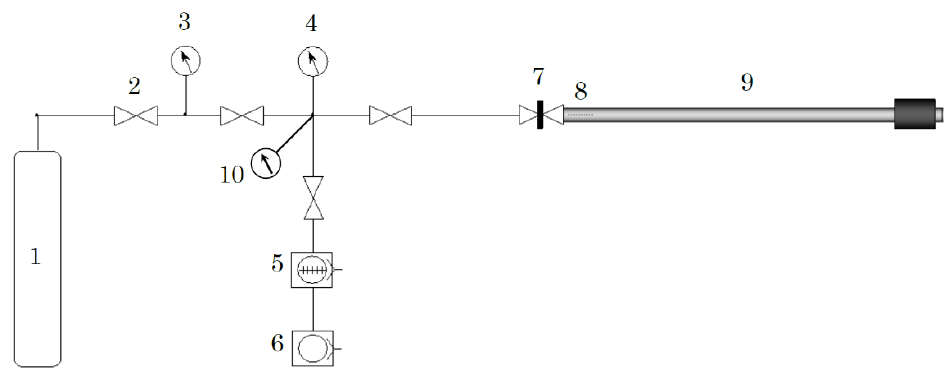
Figure 15. Schematic illustration of the home-made deuterium gas loading set up. 1: D 2 gas bottle (99.98%), 2: variable leak valve, 3: capacitance manometer 10 5 Pa max., 4: capacitance manometer 100 Pa max., 5: turbo molecular pump, 6: oil rotary pump, 7: gate valve, 8: sample mounted on transfer rod, 9: magnetic transfer rod with sample, and 10: vacuum gauge.